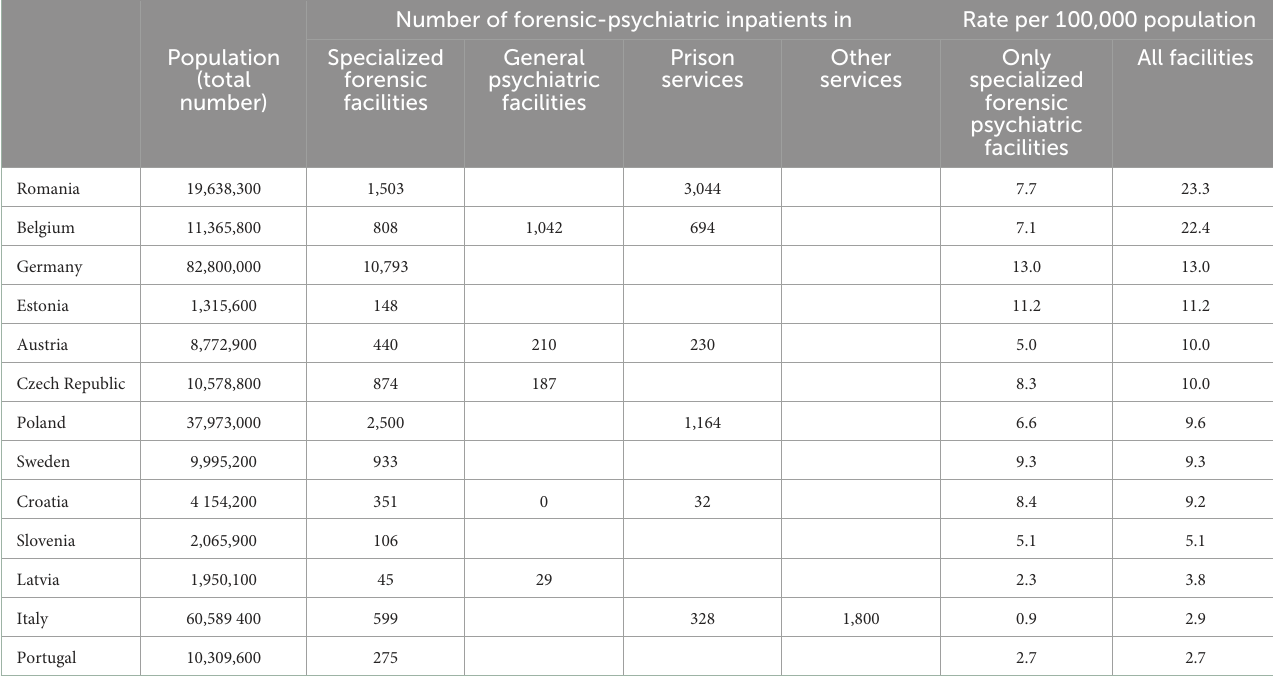
Germany:Datafrom12outof16federalstates. Poland:Specializedforensicfacilitiesdataestimated. CzechRepublic:Generalpsychiatricfacilitiesdatafrom2016. Latvia:GeneralpsychiatricfacilitiesandprisondataonlycoveringtheregionoftheCapitalofRiga. Italy:“Otherservices”represents“controlledfreedom”regimes.